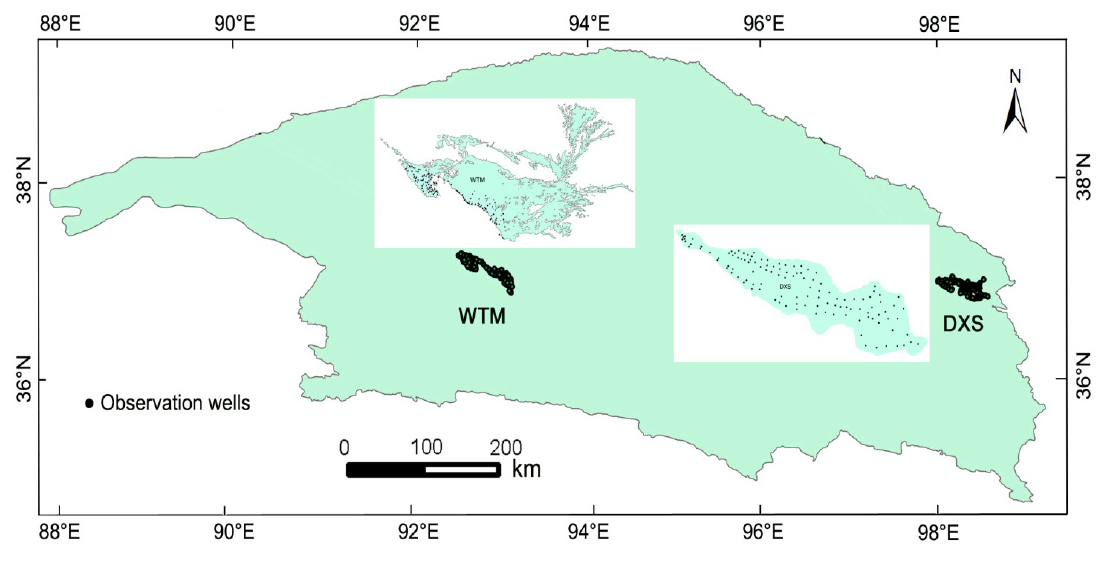
Figure 2. Distribution of groundwater observation wells in WTM and DXS